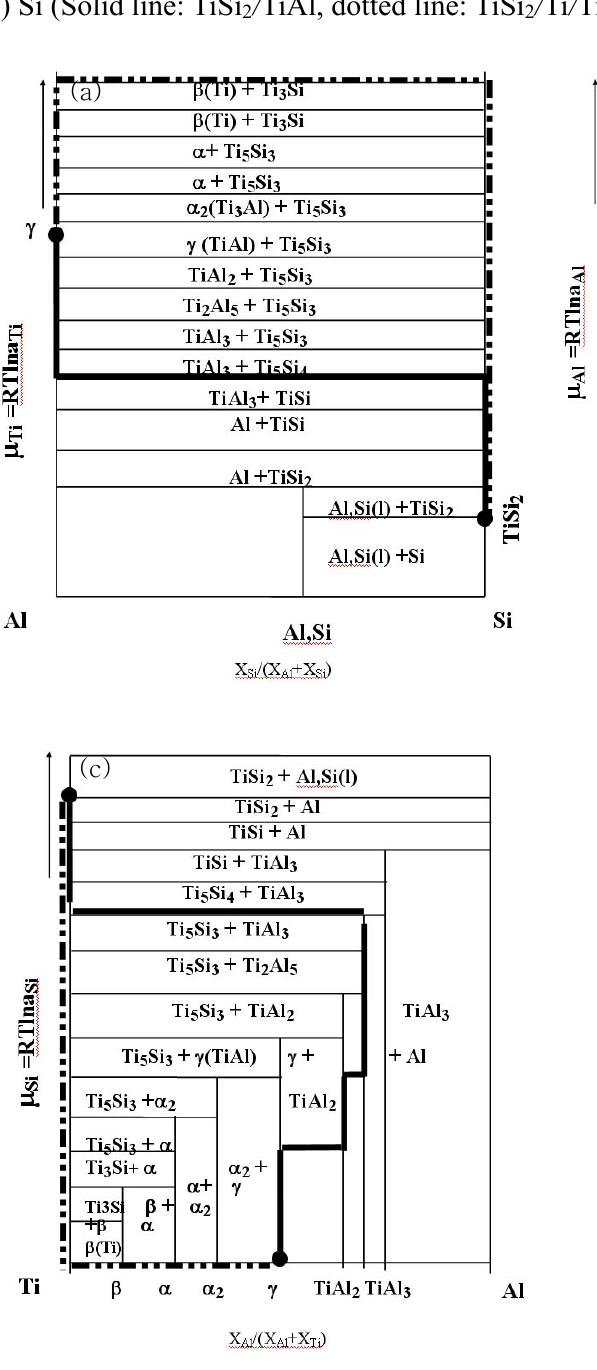
Figure 18. The stability diagram of Ti-Ai-Si ternary system with respect to (a) Ti (b)Al and / TiAl, dotted line: TiSi / Ti / TiAl) (c) Si (Solid line: TiSi 2 2